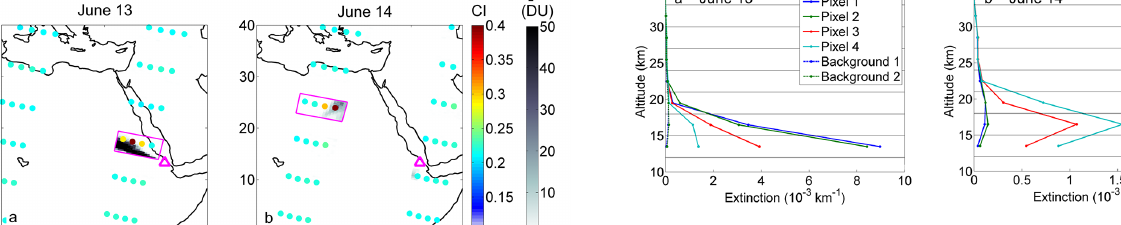
Figure 5. Limb extinction profiles of all limb pixels in the SCIA- MACHY state containing parts of the SO 2 plume on 13 June (state 20 of orbit 48555; panel a ) and on 14 June 2011 (state 19 of orbit 48570; panel b ). The resolution of the instrument is indicated by the black grid lines. The two profiles labelled “Background” (dashed lines in panel a ) are the profiles from pixels 1 and 2 on 14 June (panel b ). Note that the panels have different x -axis scales. Pixel enumeration is from West to